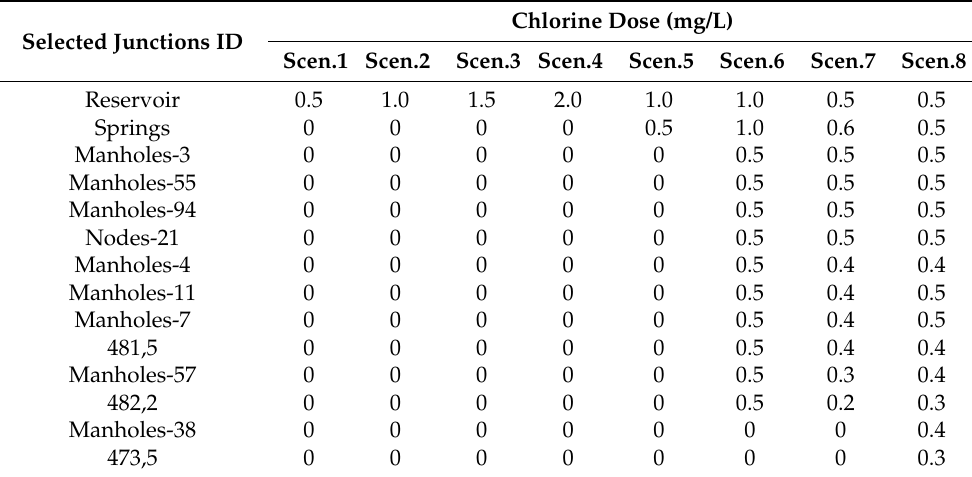
Table 5. Chlorine doses (mg/L) applied at booster stations for scenario